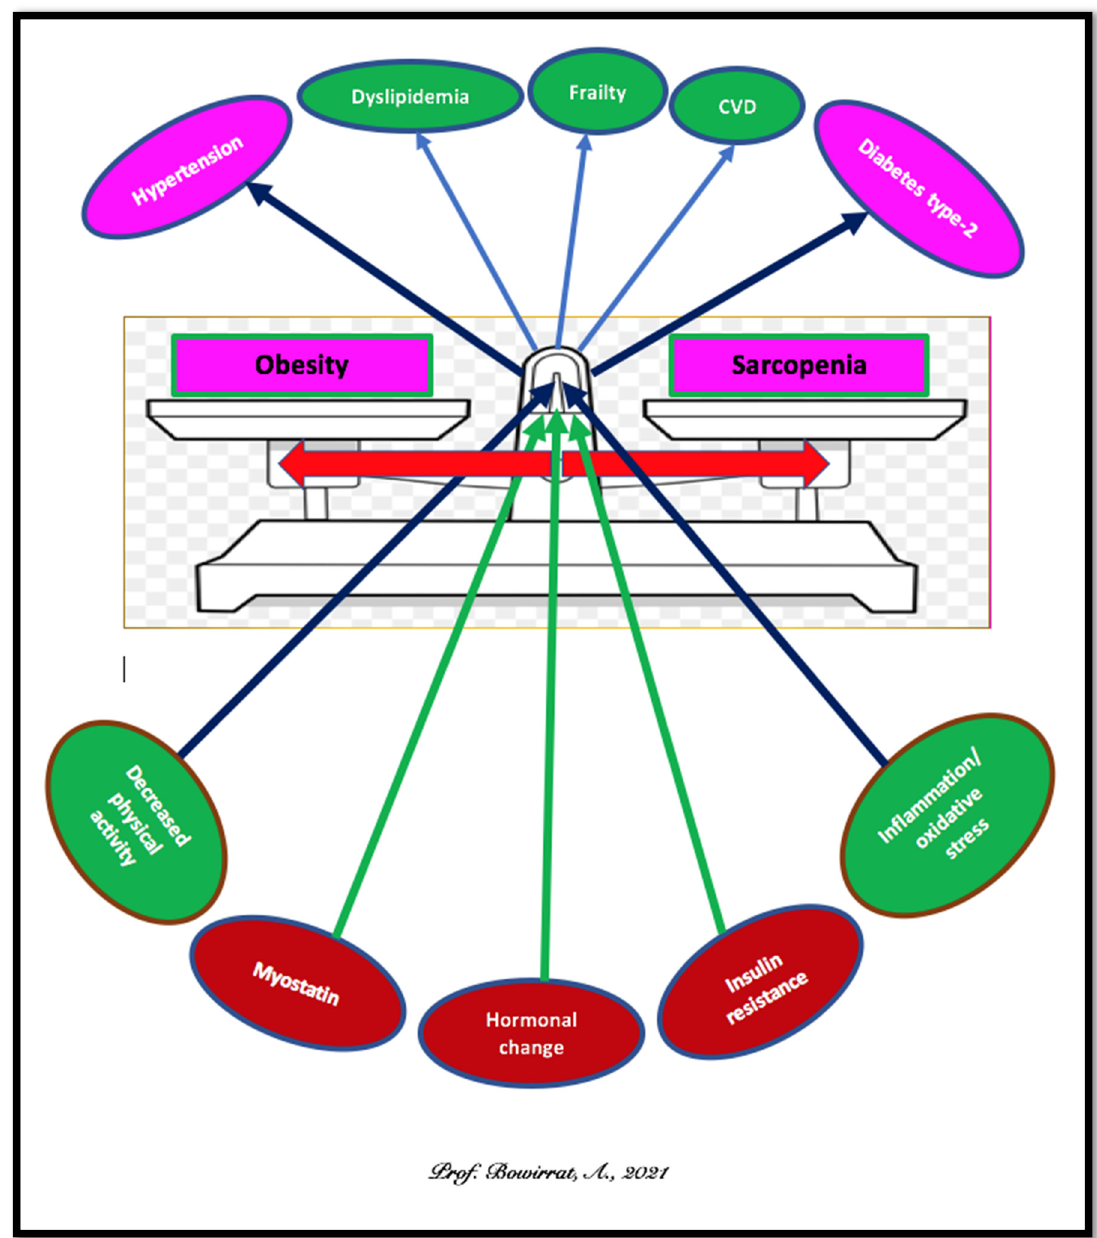
Figure 4. Mechanisms, consequences of Sarcopenia and obesity.